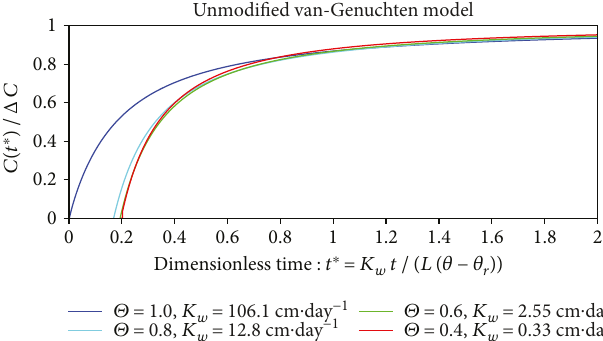
Figure 6: E ff ect of e ff ective saturation on breakthrough curves for sandy loam soil for the unmodi fi ed Mualem-van Genuchten